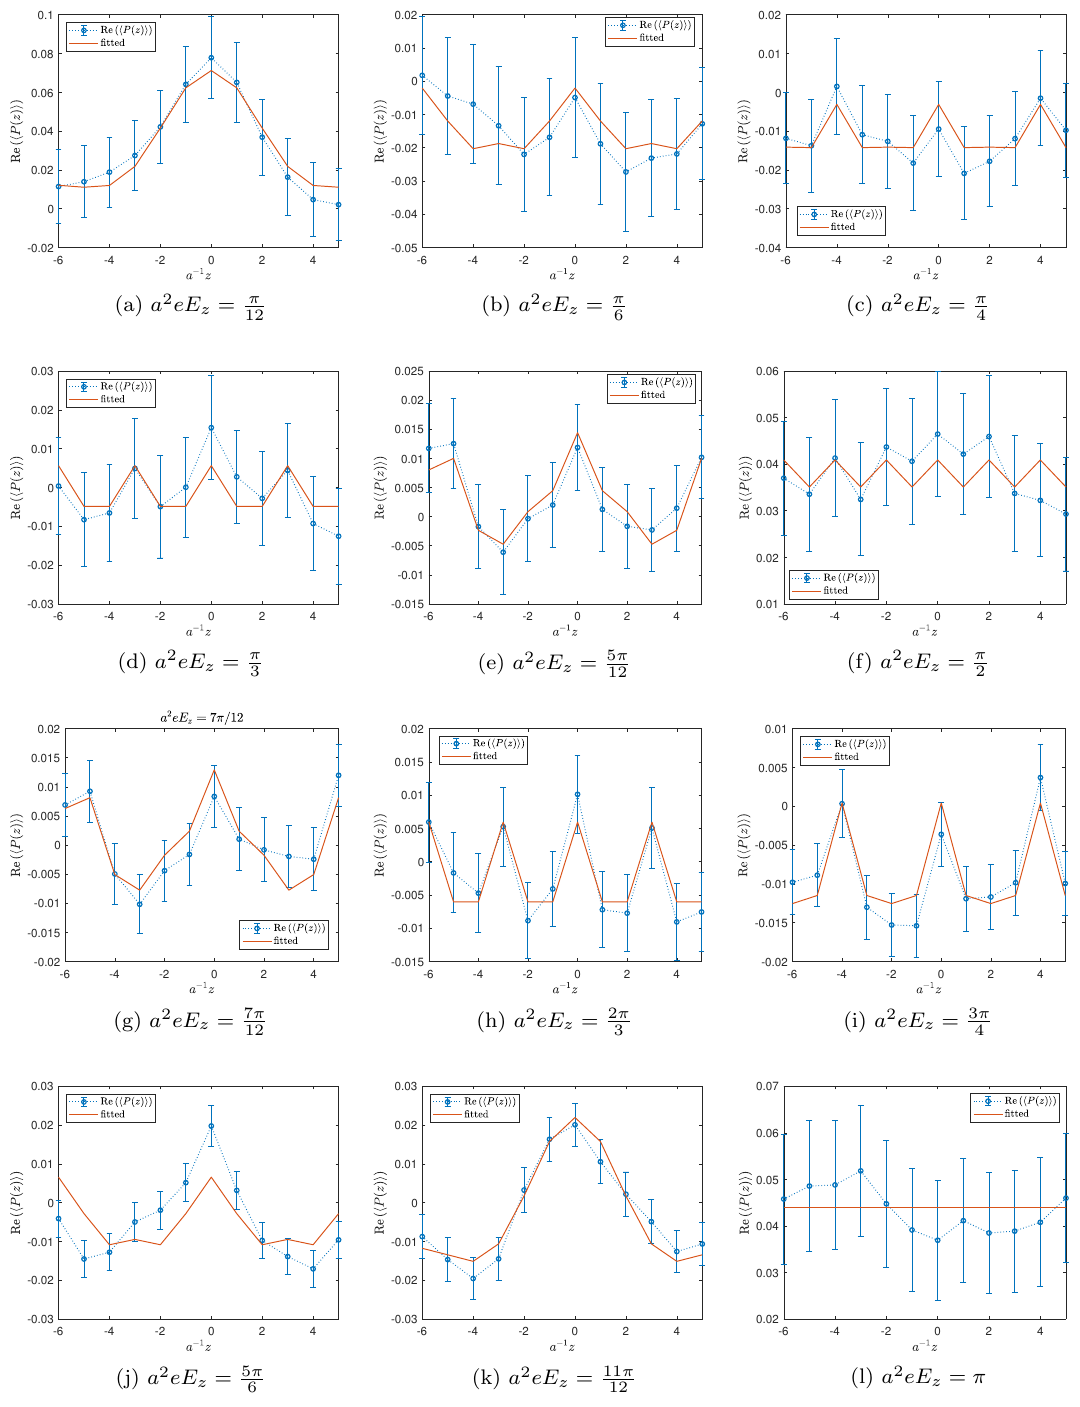
Figure 30 . Same as figure 6 but for Re ( h P ( z ) i ) at β = 5 . 42